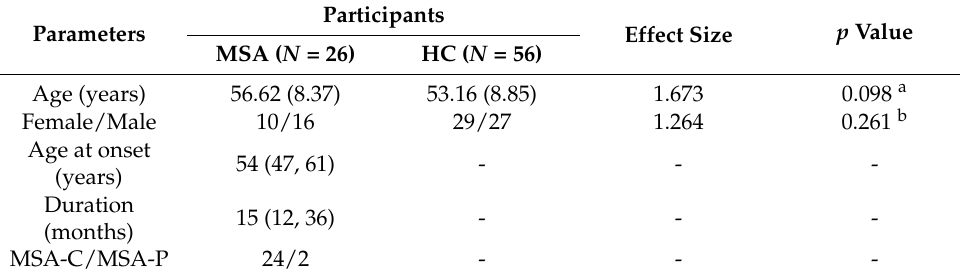
Table 2. Demographic and clinical characteristics.